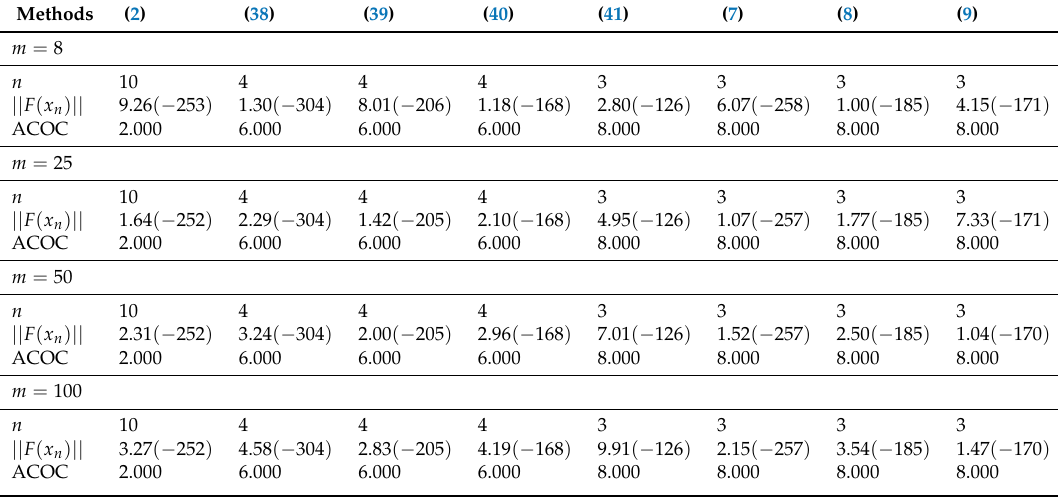
Table 4. Comparison of performance of methods for Example 4. Approximate computational order of convergence (ACOC).